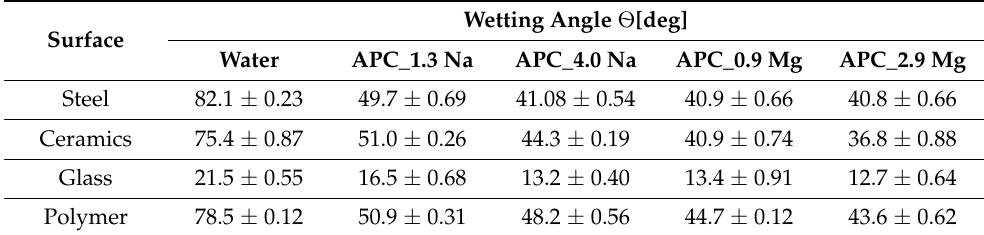
Table 2. Wetting angle of APCs as 1% solutions for various surface